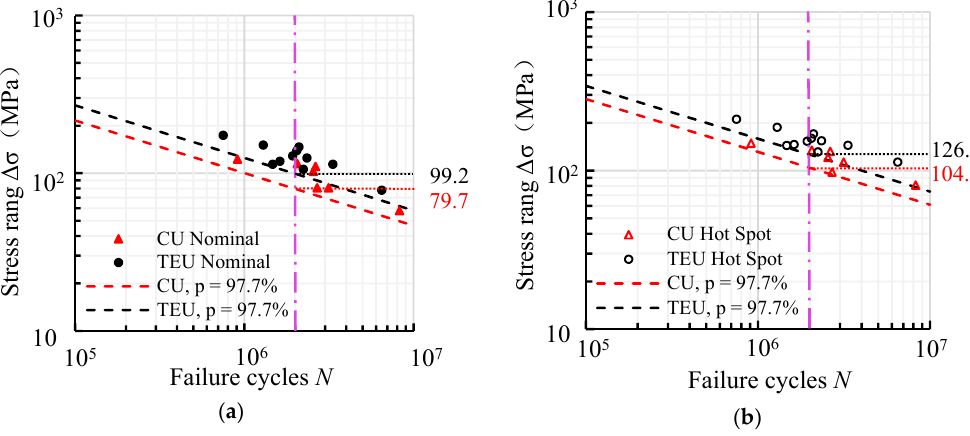
Figure 8. P–S–N curve under the survival rate of 97.7%: ( a ) nominal stress and ( b ) hot spot stress.